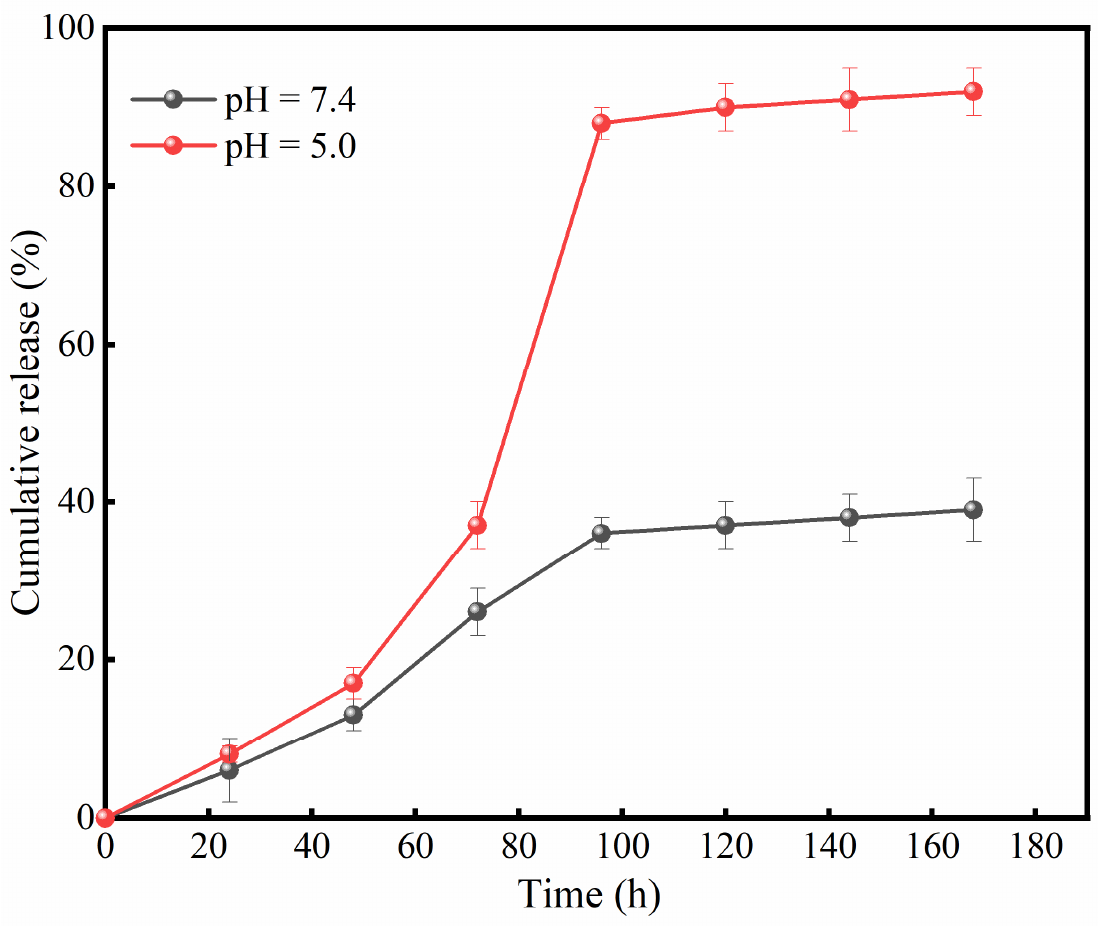
Figure 6. Release of PTX from PTX/6- β -CD-N-ODMA in PBS (pH = 7.4 or 5.0) with 1% Tween 80 at 37 °C. Table 4. Representative models used for describing kinetics of PTX released.